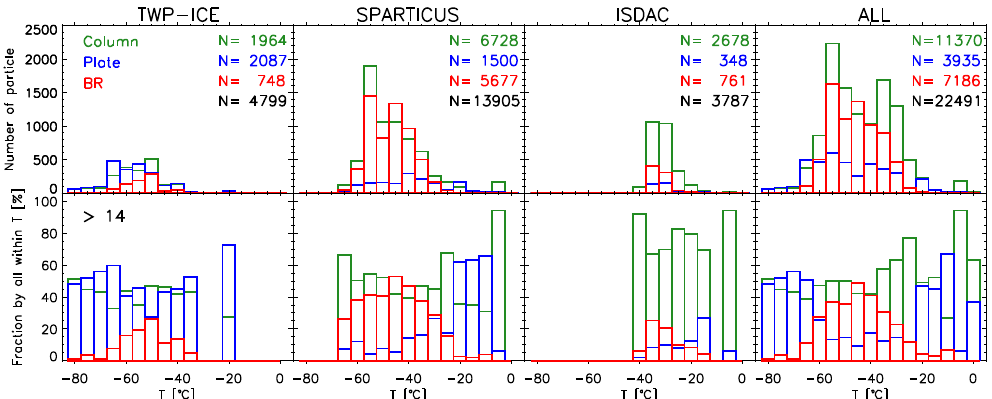
Figure 4. Numbers of particles measured during TWP-ICE, SPARTICUS, ISDAC, and all three campaigns (ALL) as a function of temper- ature in the top row. The corresponding fraction (%) normalized by total numbers of all three habits within temperature bins in which more than 14 samples are available is shown in the bottom row. Different colors indicate different crystal habits, and the total numbers of each habit and of all three habits are